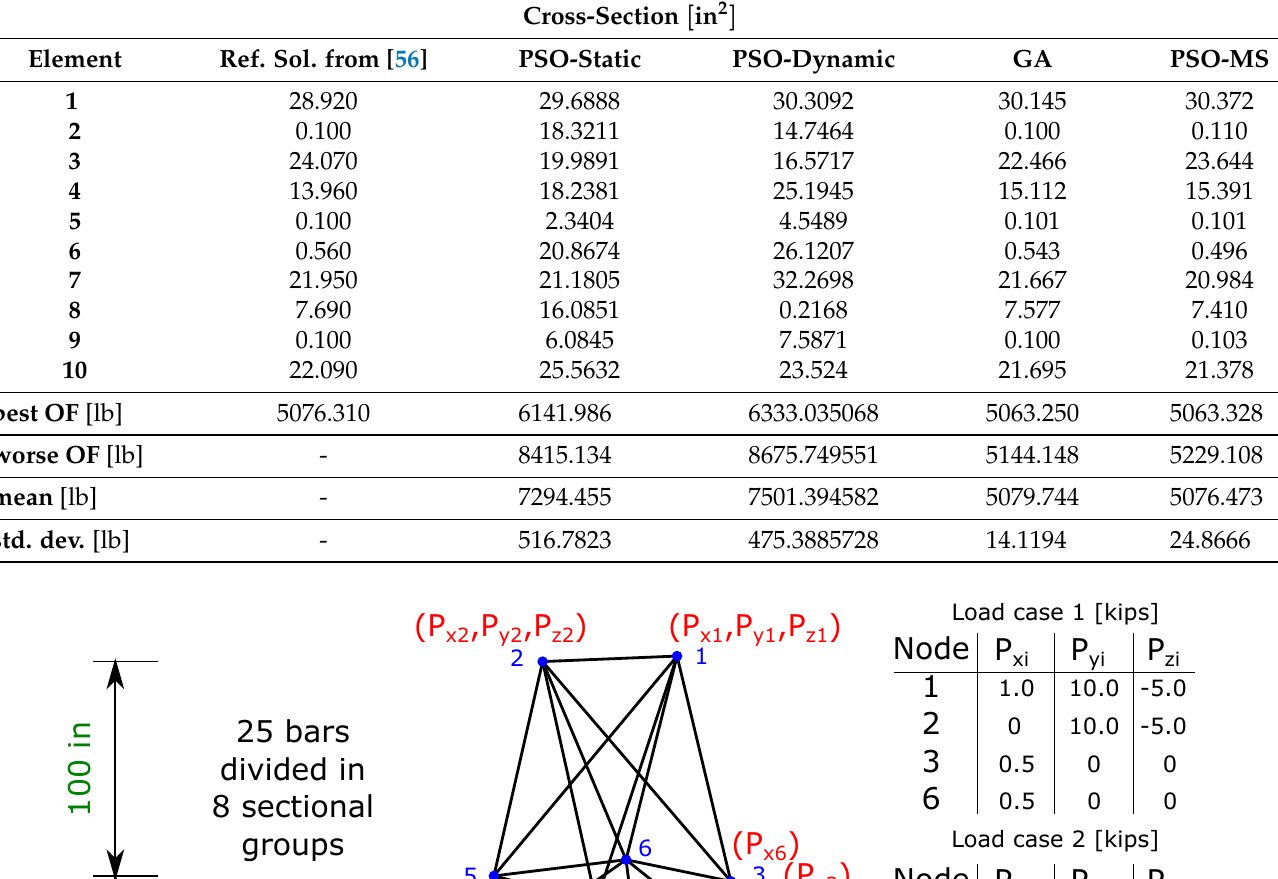
Table 2. Ten-bar truss design example: results comparisons for 100 runs among the enhanced multi- strategy PSO ( PSO-MS ), the PSO with static penalty ( PSO-Static ), and the PSO with dynamic penalty ( PSO-Dynamic ) and GA.